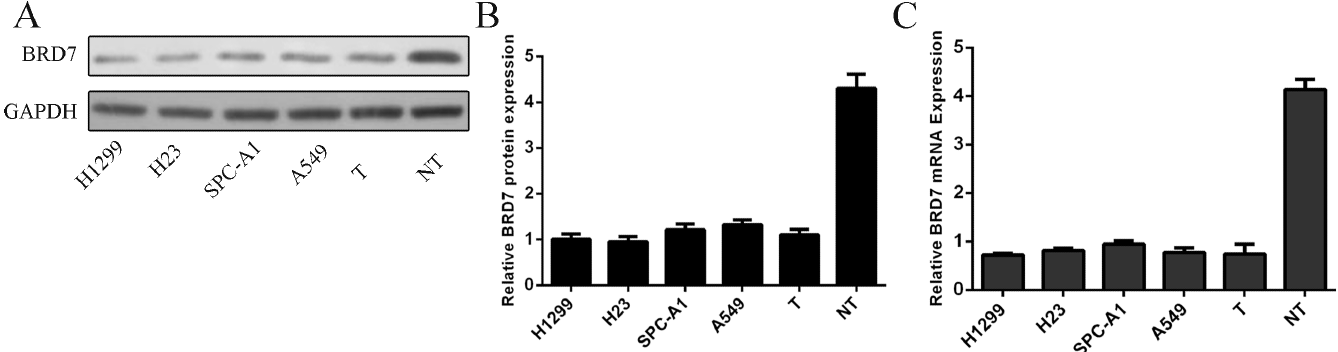
Fig 1. The expression level of BRD7 was downregulated in lung adenocarcinoma cell lines. (A) The protein expression level of BRD7 in four lung adenocarcinoma cell lines (H1299, H23, SPC-A1 and A549) and one lung adenocarcinoma tissues and adjacent no-tumor tissue was measured by Western blot. (B) The signal in each lane was quantified using ImageJ software and the ratio of BRD7 to GAPDH was determined. (C)The mRNA expression level of BRD7 in four lung adenocarcinoma cell lines (H1299, H23, SPC-A1 and A549) and one lung adenocarcinoma tissues and adjacent no- tumor tissue was measured by